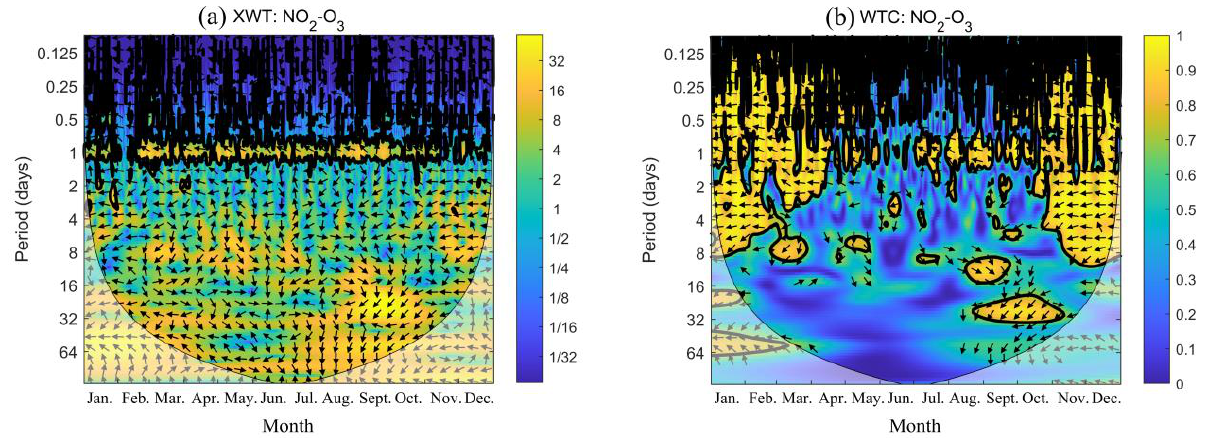
Figure 3. ( a ) Cross wavelet spectrum (XWT); ( b ) wavelet coherence spectrum (WTC) of NO 2 and O 3 . The left axis represents the period, the right axis represents the intensity of the com- mon period in the XWT and the consistency of the changing trends in the WTC, and the bottom axis represents time. The yellow represents a larger correlation coefficient and blue represents a smaller correlation coefficient. The area surrounded by the thick black solid line indicates the area that passes the 95% red noise confidence test, and the black solid line envelope is the conical influence domain; the relative phase relationship is indicated by the arrows (in phase points to the right, antiphase points to the left, NO 2 leads O 3 1/4 period when pointing straight up).